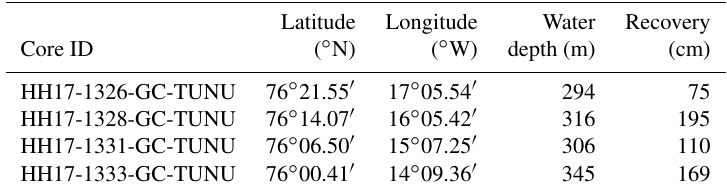
Table 1. Core locations, water depths and